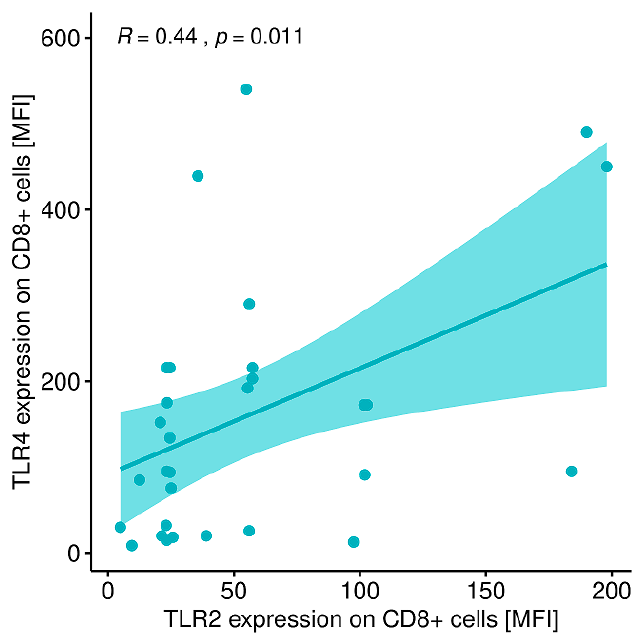
Figure 10. Correlation between the expression level of TLR-2 on CD8 + T lymphocytes (MFI) and the expression level of TLR-4 on CD8 + T lymphocytes (MFI). MFI, mean fluorescence intensity.